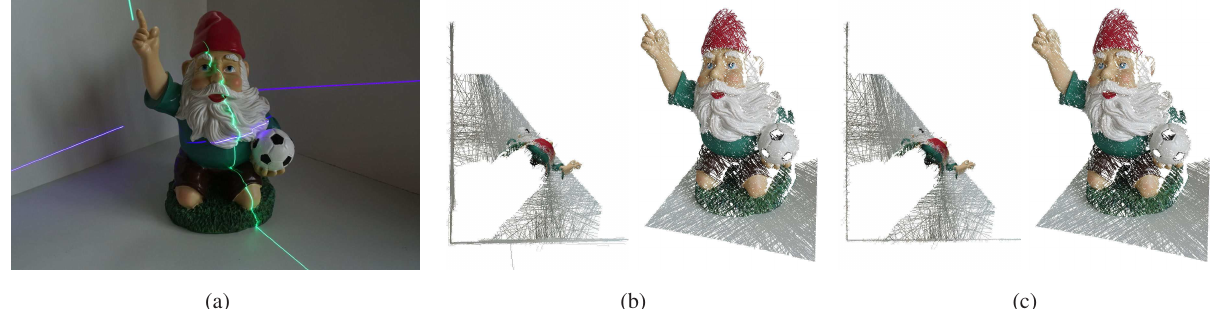
Figure 4: Setup for comparison with explicit plane parameter estimation: (a) object with three known reference planes in the back- ground, (b) top and detail view of the 3D reconstruction using the proposed method, (c) top and detail view of the 3D reconstruction based on the calibrated reference